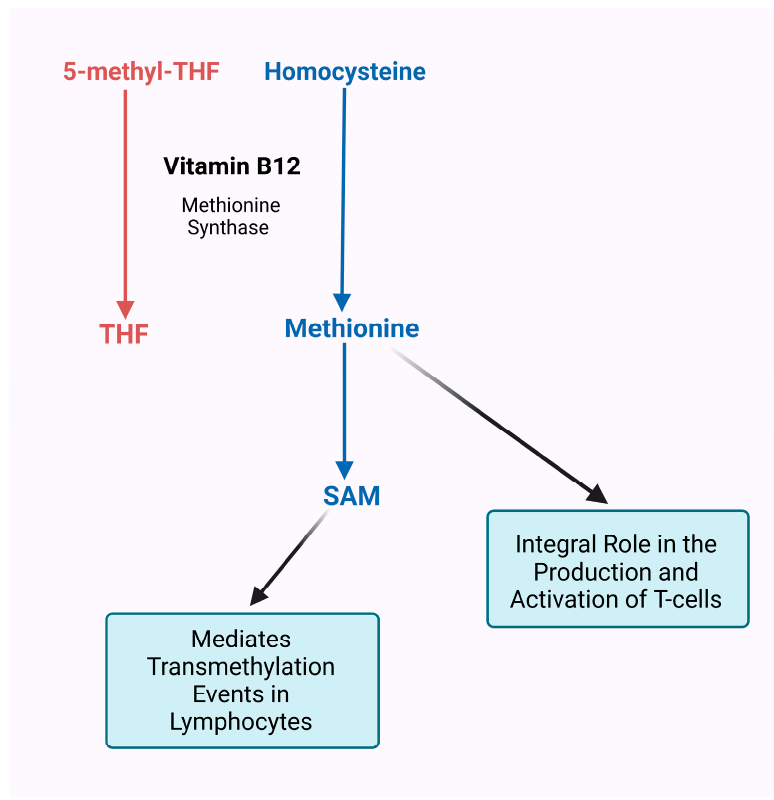
Figure 3. Vitamin B12 and 5-methyl-tetrahydrofolate (THF) interact to produce methionine for T cell activation. Methionine synthase is a vitamin B12-dependent enzyme that produces methionine via homocysteine and 5-methyl-THF. The uptake of methionine is required in T-cells to provide methyl groups to RNA and DNA, needed for the cells to proliferate and differentiate. The absence of methionine leads to the failure of T-cell expansion and a weakened cell-mediated immune response. Methionine is essential to synthesize S-adenosylmethionine (SAM), which plays a major role in transmethylation reactions that support immune function. Lymphocytes depend upon SAM in activated states for transmethylation events involving DNA, RNA, or protein molecules, which are required for maintaining cell